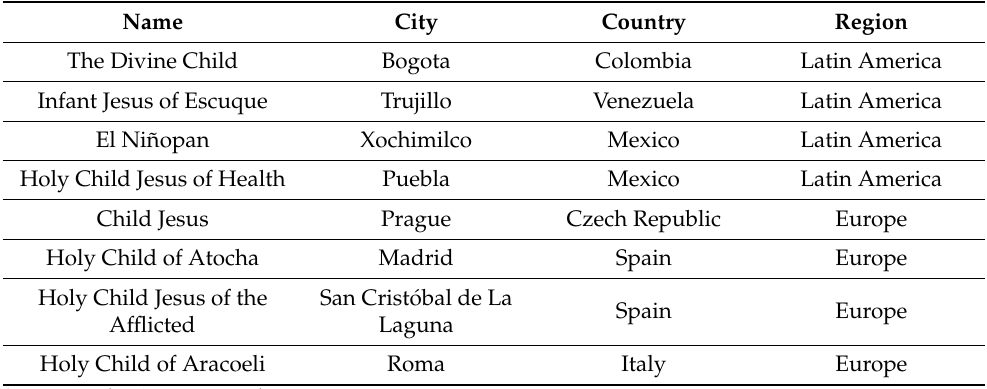
Table 1. Devotions to the child Jesus in the